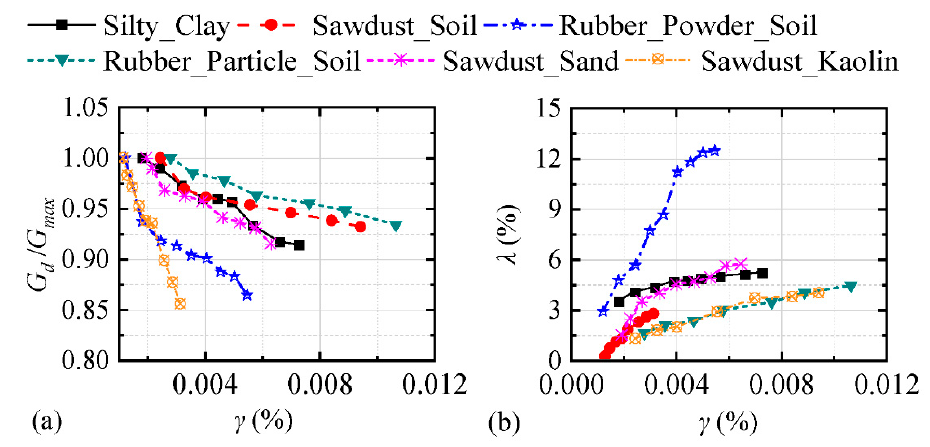
Figure 9. Comparison curve of dynamic characteristics between undisturbed soil and five models when confining pressure was 50 kPa: ( a ) Normalized dynamic shear modulus, ( b ) Dynamic damping ratio.